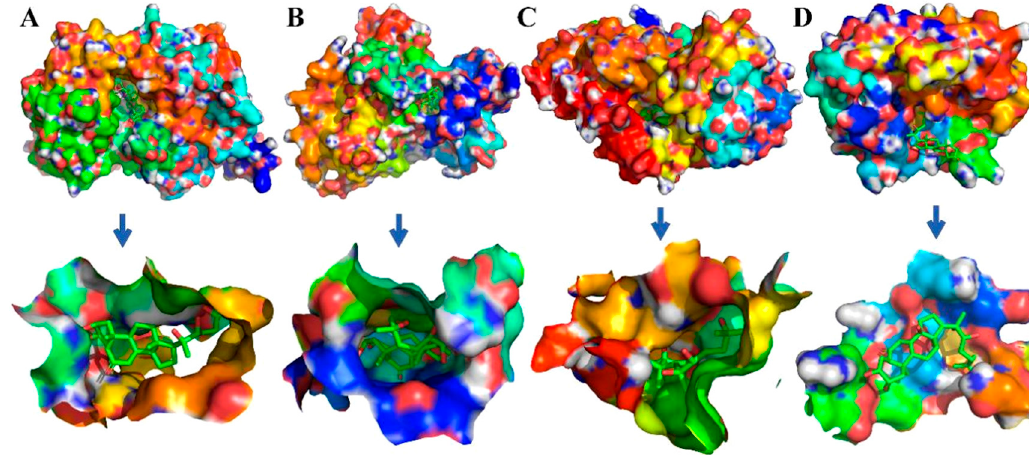
Figure 10. Binding cavity snapshots of Ecdysterone and four representative receptors. ( A ) F2- Prothrombin. ( B ) GSK3B-Glycogen synthase kinase-3 beta. ( C ) IDO1-Indoleamine 2,3-dioxygenase. ( D ) PRSS1-Trypsin-1.